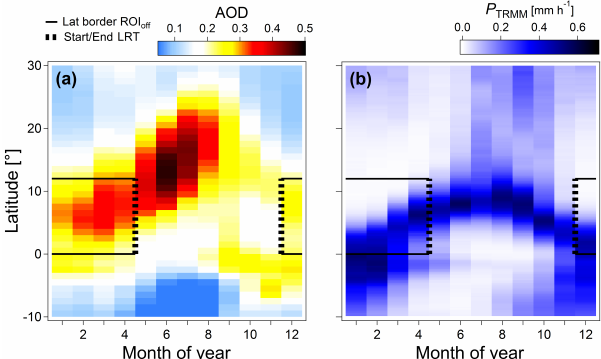
Figure 3. Longitude-averaged Hovmöller plots for (a) MODIS- derived aerosol optical depth (AOD) and (b) TRMM-derived pre- cipitation rate, P TRMM . The average AOD data represent a time period from July 2002 to June 2016. The average precipitation rate data represent a time period from December 1997 to March 2016. Long time periods have been chosen (maximum of available satel- lite data) to extract representative seasonal trends. The averaged lon- gitude range of the plots from 49 to 37 ◦ W corresponds with the longitude dimension of the ROI off in Fig. S4. The latitudinal range of the Hovmöller plots spans from 10 ◦ S to 30 ◦ N. The solid black lines mark the latitudinal margins of the ROI off (0 to 12 ◦ N) and the black dashed lines mark the start (December) and end (April) of the period when most African LRT aerosol transport towards the ATTO site has been